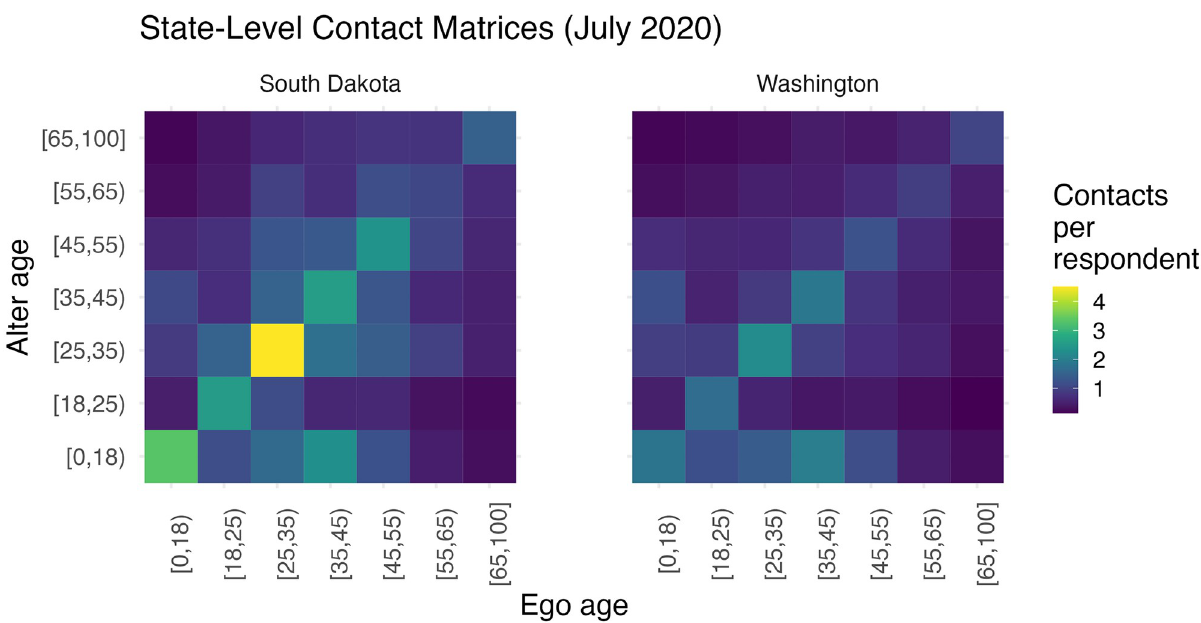
Fig 2. MRP estimates of state-level contact matrices for Washington and South Dakota in July, 2020. Each entry i , j in the contact matrix represents the average number of contacts that a person (ego) in age group i has with other people (alter) in age group j in the past 24 hours. Each cell is shaded according to the estimated mean number of total (household and non-household) contacts. The contact matrices have been adjusted for reciprocity; however, this is not necessarily reflected visually in the contact matrices due to the differential size of the population subgroups.